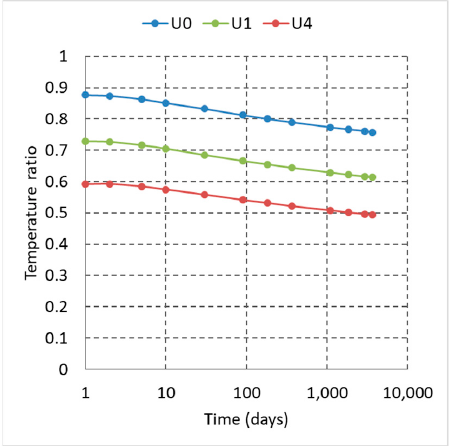
Figure 11. Outlet to bottom-hole temperature ratio vs time after